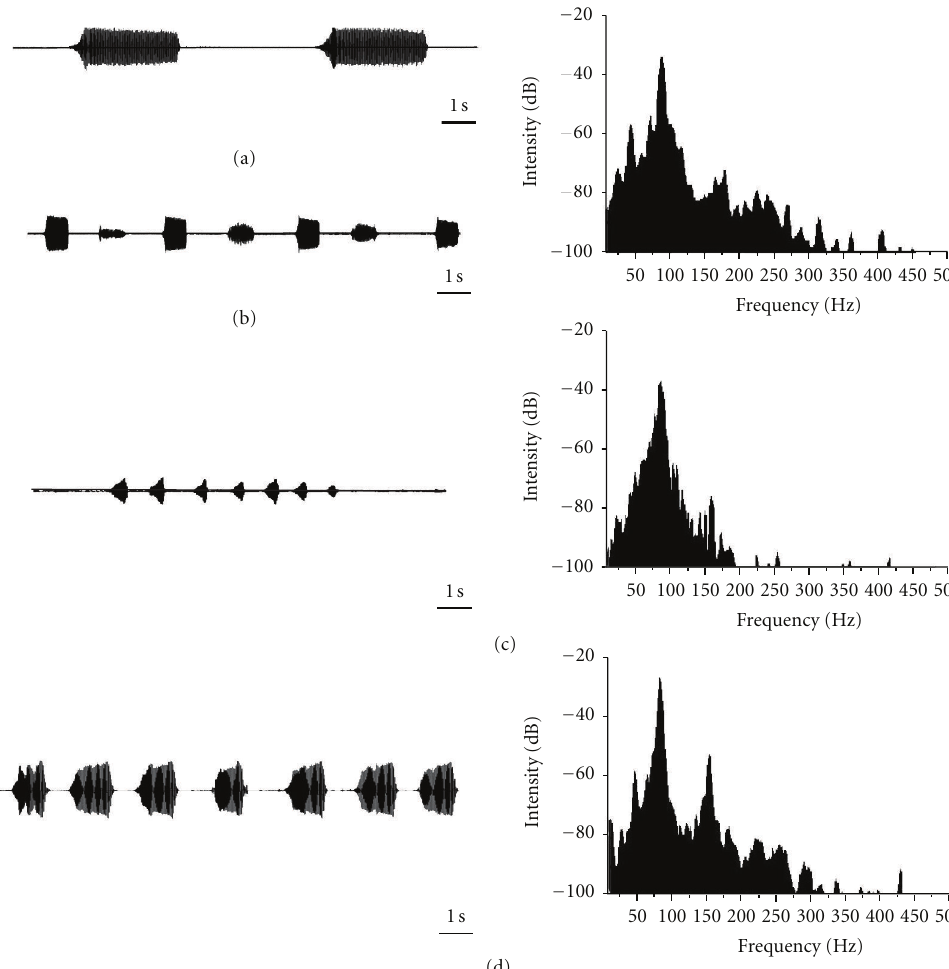
Figure 4: Oscillogram and frequency spectrum of one pulse of Edessa meditabunda vibratory songs: (a) male song 1 (MS1); (b) male rivalry song (MR); (c) male song 2 (MS2); (d) female song 1